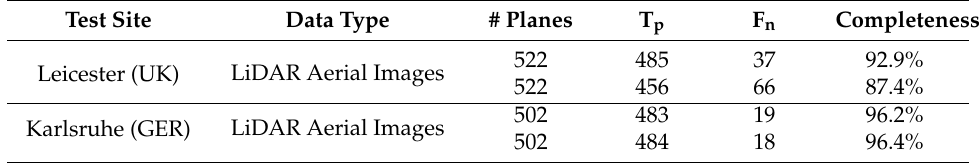
Table 4. Correctness and quality of roof plane extraction for the Leicester and Karlsruhe test site. Table 3. Completeness of roof plane extraction for the Leicester and Karlsruhe test